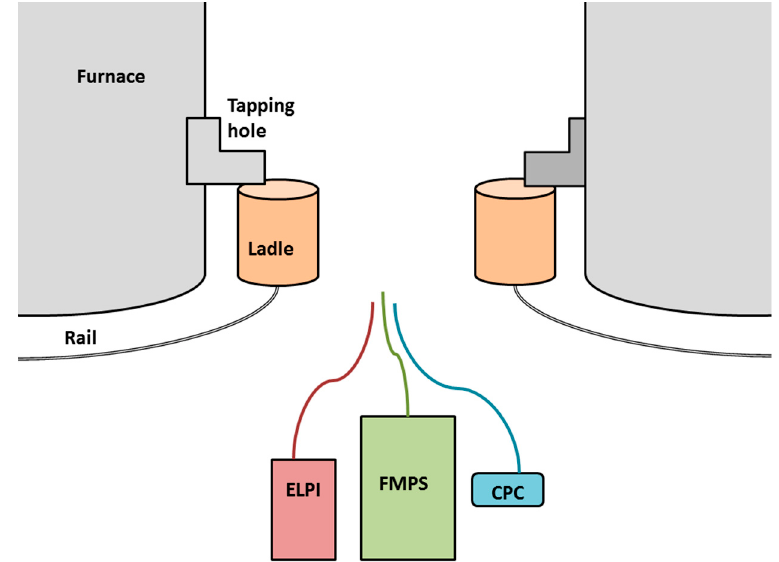
Figure 1. Schematic illustration of the placement of the instruments in the furnace tapping area between two electric arc furnaces. Both furnaces were continuously tapped.